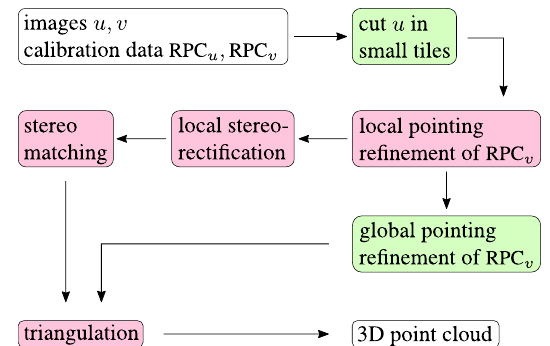
Figure 2: s2p overview. The input is a pair of images with their respective rational polynomial camera models, and the output is a digital elevation model given as a georeferenced 3D point cloud. Green blocks are applied to the whole images, while pink blocks are applied on small independent tiles. They can be processed in parallel.